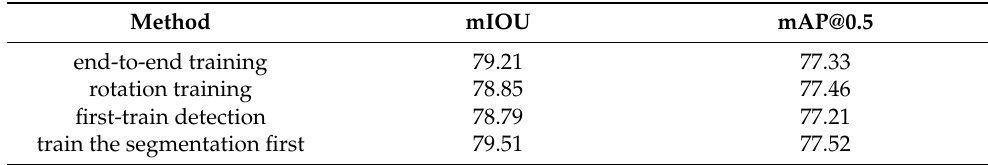
Table 1. Metrics of Different Training Strategies.